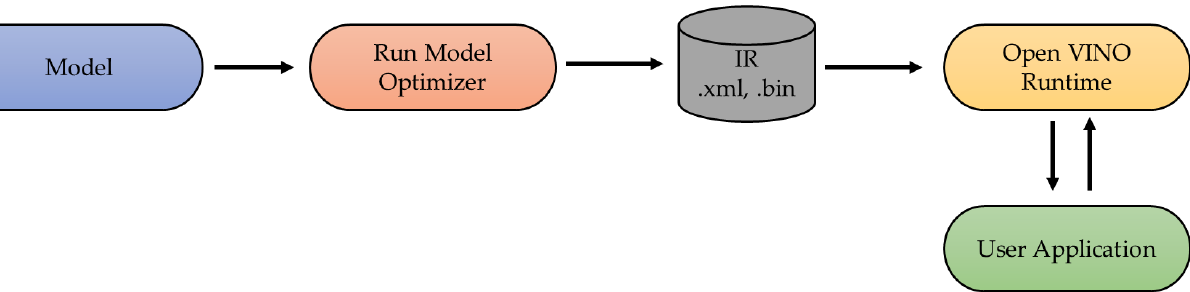
Figure 6. Block diagram for the optimisation and implementation with Intel OpenVino.